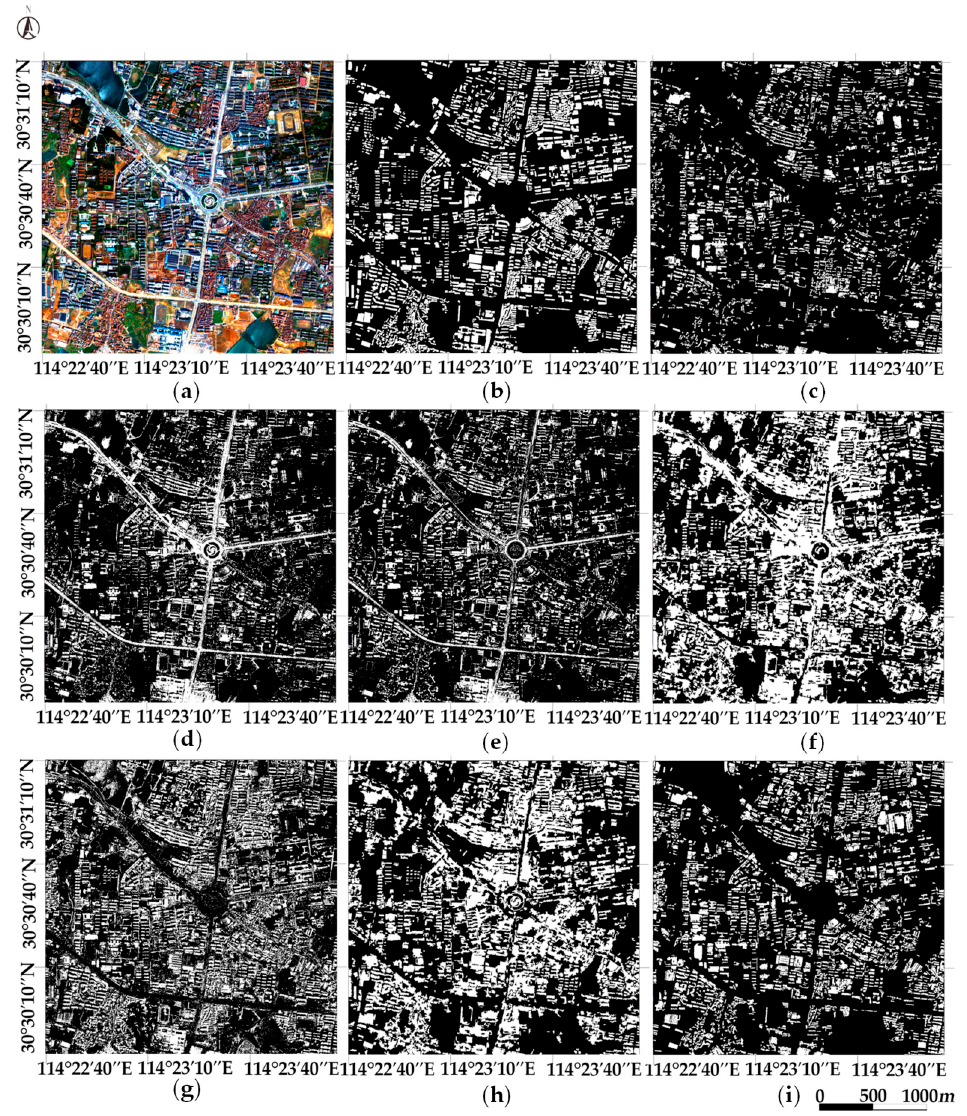
Figure 7. Building feature extraction results for Dataset 2: ( a , b ) the RGB image and the ground truth map; ( c ) the building detection result of the MBI; ( d – f ) the building maps with the results of the pixel-based SVM, DMP-SVM, and object-oriented SVM, respectively; ( g , h ) the building detection results of DMP-RF and object-oriented RF; ( i ) the results of the proposed